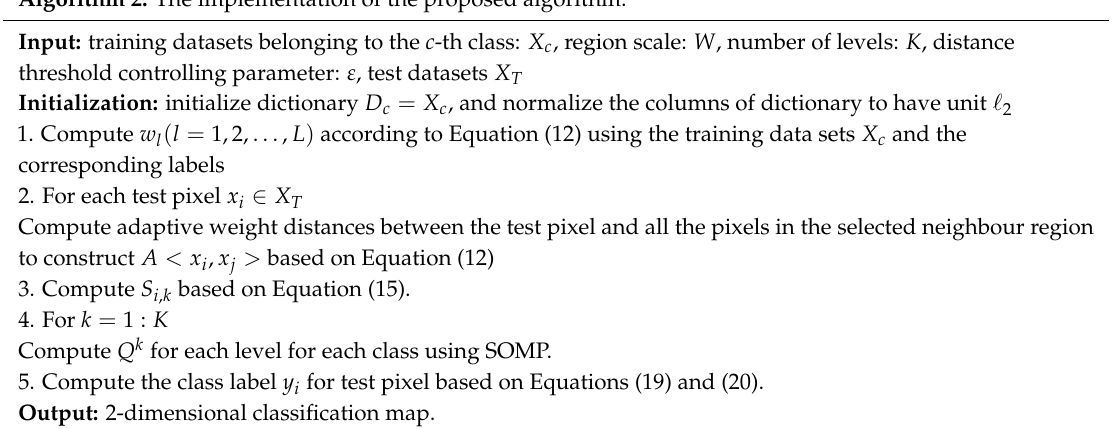
Algorithm 2. The implementation of the proposed